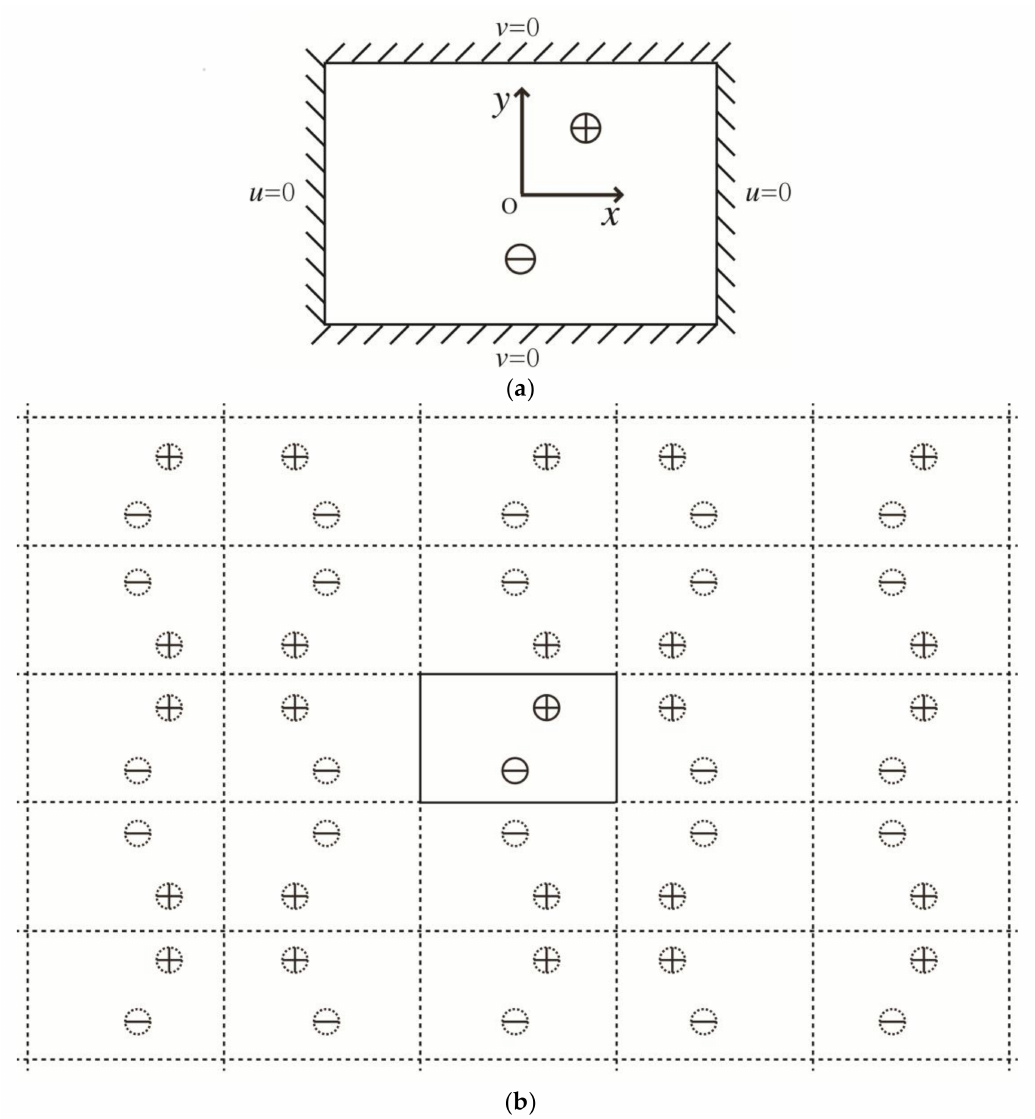
Figure 1. Schematics of defined problem and mirror image distribution. ( a ) The defined problem domain with boundary conditions; ( b ) Mirror image distribution for satisfying the specified boundary conditions. Circles with positive sign represent injection wells (point sources for porous flow), while those with negative sign represent production wells (point sinks for porous flow), with solid circles being corresponding to real source/sink and dotted circles being corresponding to mirror